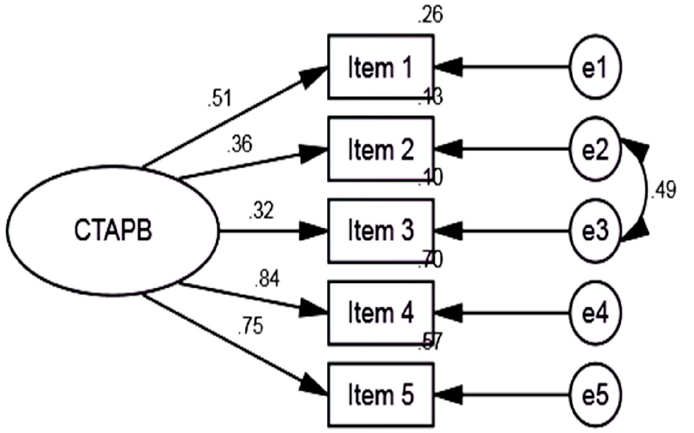
Figure 1. CFA model of latent factor of Compulsory Temporary Afterlife Punishment Belief (CTAPB)—Study 1.